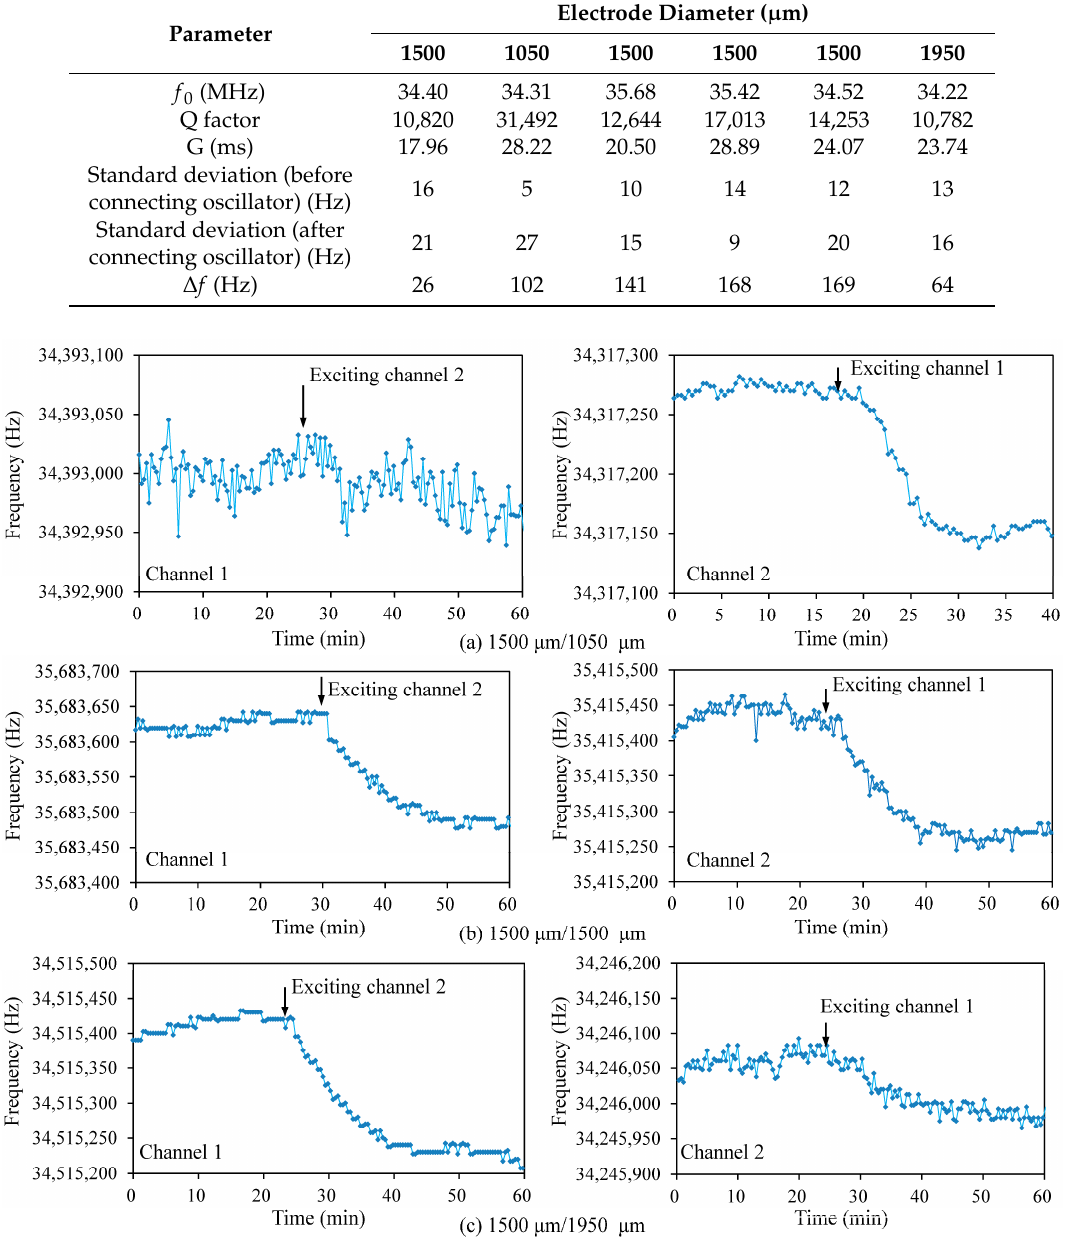
Table 1. Measured characteristics of Dual-channel QCM.